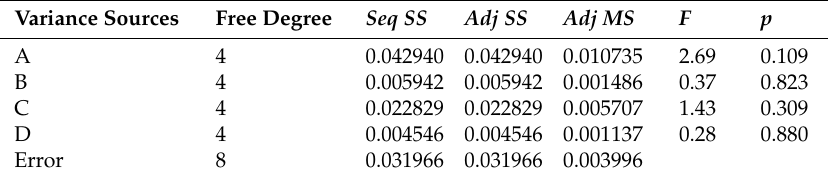
Table 5. The variance analysis of similar-material density ( Seq SS : the sum of the squares of deviations; Adj SS : adjusted squares sum of deviations; Adj MS : adjusted squares sum of mean-square